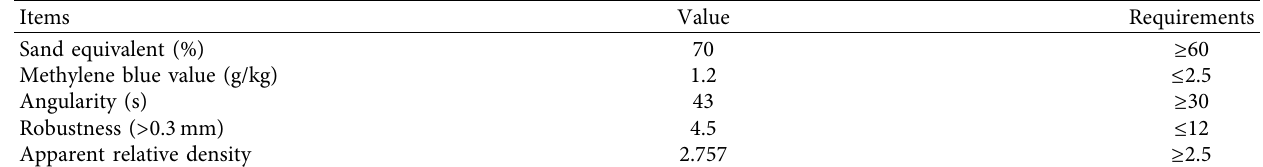
Table 6: Test results of physical properties of manufactured sand.